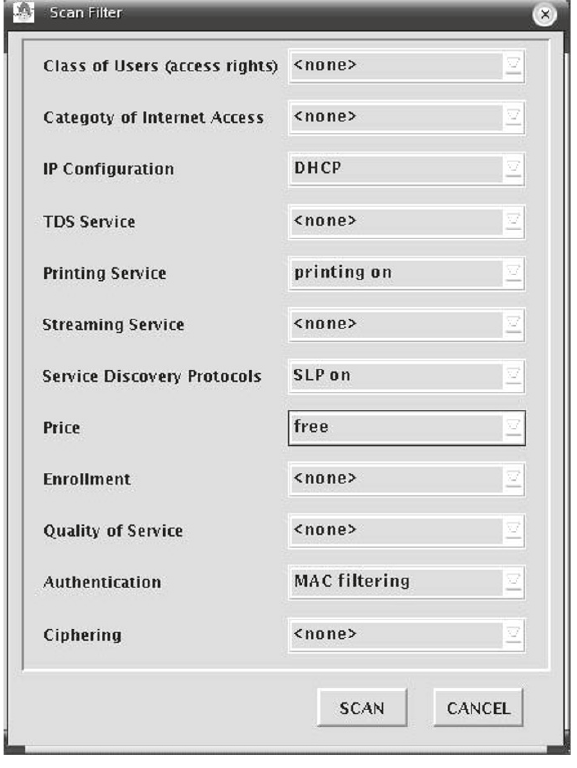
Figure 5: TWS: panel to set user preferences.